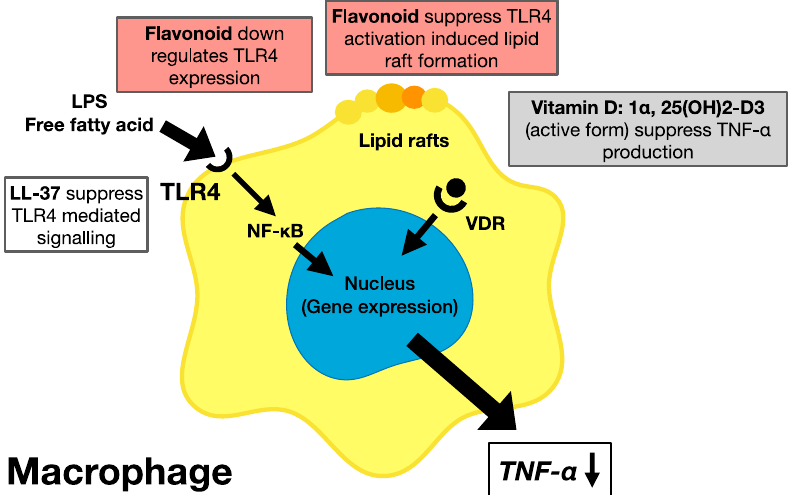
Figure 5. Molecular mechanism for the suppression of TNF- α and chronic inflammation. This figure shows molecular mechanism of TNF- α suppression and chronic inflammation by phytochemicals, flavonoid, and vitamin D. TNF- α induces chronic inflammation and related disorders and finally induces metabolic syndrome. Flavonoid quercetin reduces the expression of toll-like receptor 4 (TLR4) on the surface of macrophage and suppresses the formation of lipid raft on the cell membrane. Suppression of TLR4 stops activation of the NF- κ B signalling pathway. In addition, vitamin D-enhanced LL-37 also suppress the activation of transcription factor NF- κ B via TLR4 stimulation. Then, the active form of vitamin D, 1 α , 25(OH)2-D3, conjugates with the vitamin D receptor (VDR) in the cytoplasm and is translocated to the nucleus. The vitamin D-VDR complex attaches to the gene promoter region of TNF- α and stops production of TNF- α . Interaction between phytochemicals and vitamin D suppress the production of TNF- α and induction of chronic inflammation. Finally, lowered TNF- α production suppresses the chronic-inflammation-related disorders including diabetes, cardiovascular diseases, and Alzheimer’s and suppresses metabolic